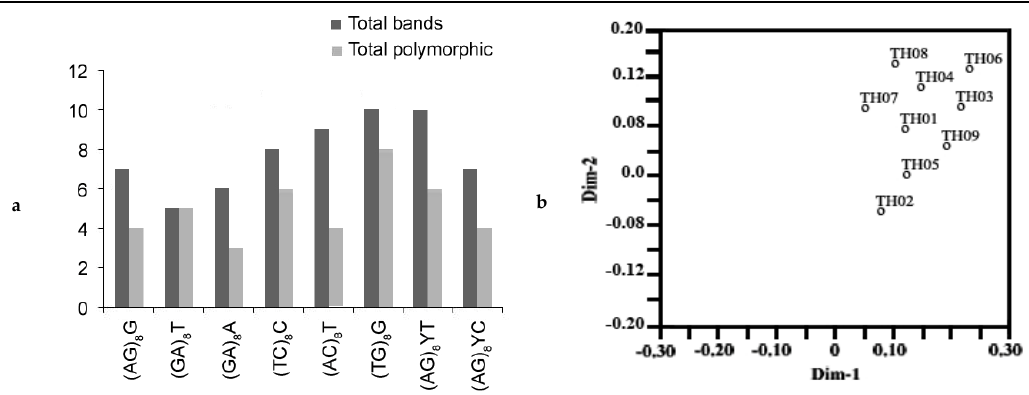
Figure 6. ( a ) Bar graph for nine T. harzianum showing various fragments produced by primers and total polymorphisms produced by them, ( b ), 2D principal component analysis (PCA) based on genetic relationships from ISSR data using the DECENTER and EIGEN features of NTSYSpc.